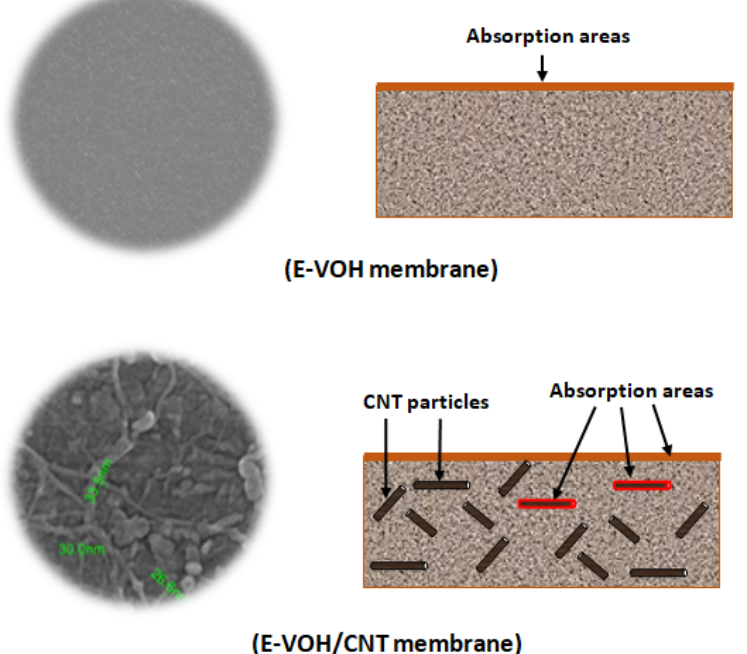
Figure 13. Change in the separation factor for benzene/cyclohexane mixture with different compositions versus time in the